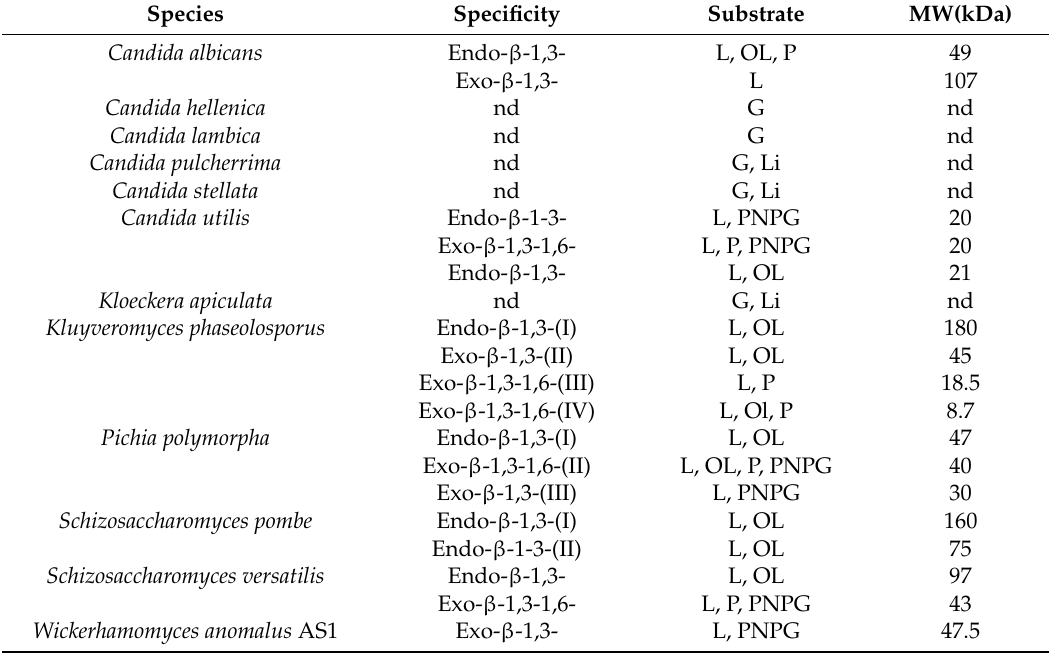
Table 4. Glucanases of non- Saccharomyces yeasts with possible use for winemaking modified from